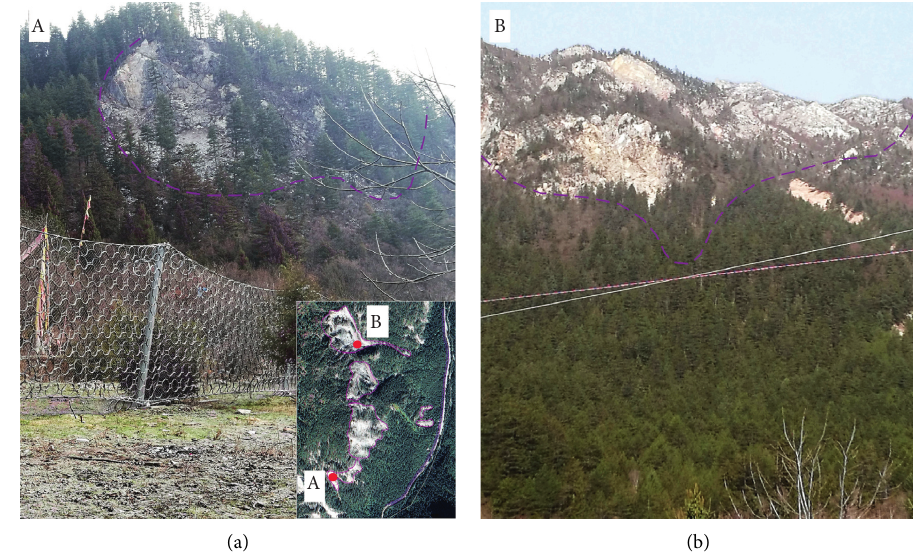
Figure 9: Field validation at points A and B shows that 1m DEM data constructed by high-precision airborne LiDAR is more valuable for collapse risk analysis than DEM data of 12m and